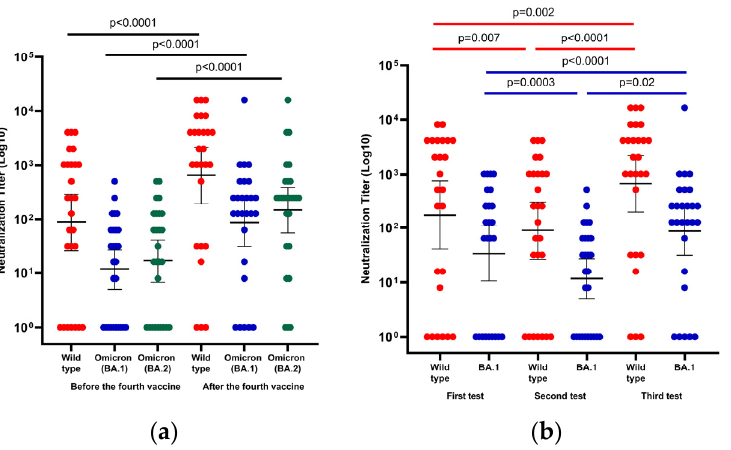
Figure 3. Neutralization efficiency against the wild-type SARS-CoV-2 virus and Omicron variants of concern BA.1 and BA.2. ( a ) Scatter plot presenting changes in wild-type, BA.1 and BA.2 Omicron neutralizing antibodies before and after the fourth vaccine; ( b ) Changes in titers of neutralizing antibody against the wild-type virus and BA.1 variant among 27 liver transplant recipients who had paired serology samples after the third and the fourth vaccine dose (in the first test, serum collection was 22 days (IQR, 21–28 days) after the third vaccine, in the second test it was 131 days (IQR, 129–137 days) after the third dose, and in the third test it was 29 days (IQR, 25–33 days) after administration of the fourth vaccine dose). Differences in paired samples were calculated using the Wilcoxon matched-pairs signed-rank test. The black horizontal line indicates geometric mean values with a 95% confidence interval.